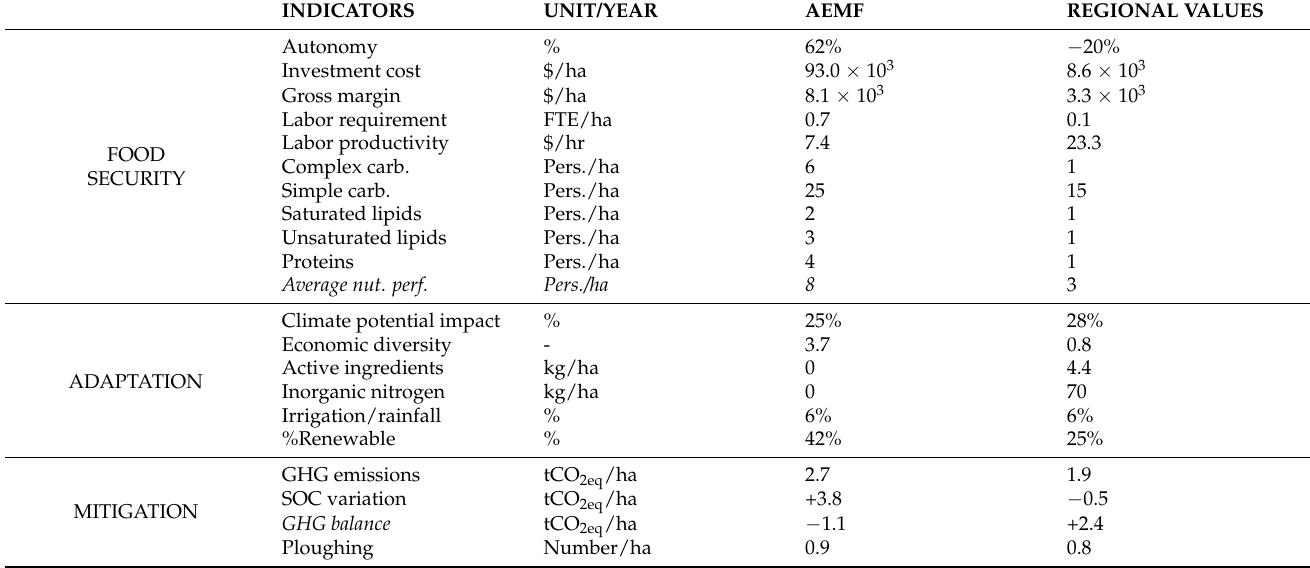
Table 3. Results of the indicators for the AEMF using the data collected during the first two years of implementation. The results were compared with the average values obtained for the regional farming system (Supplementary Materials). Corresponds to 16.5 $/hr for the AEMF in the case of household